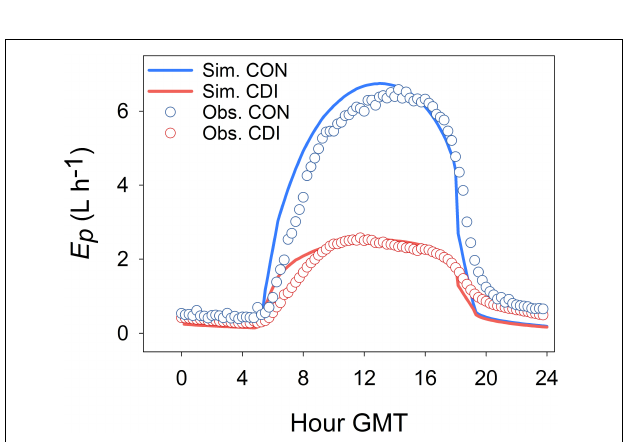
FIGURE 3 | Time course of simulated and observed daily transpiration ( E p ) throughout the 2006 season for the three irrigation treatments of Experiment I: the fully irrigated control (CON) (A) , the continuous deficit irrigation (CDI) (B) , and the regulated deficit irrigation (RDI) (C) treatments.